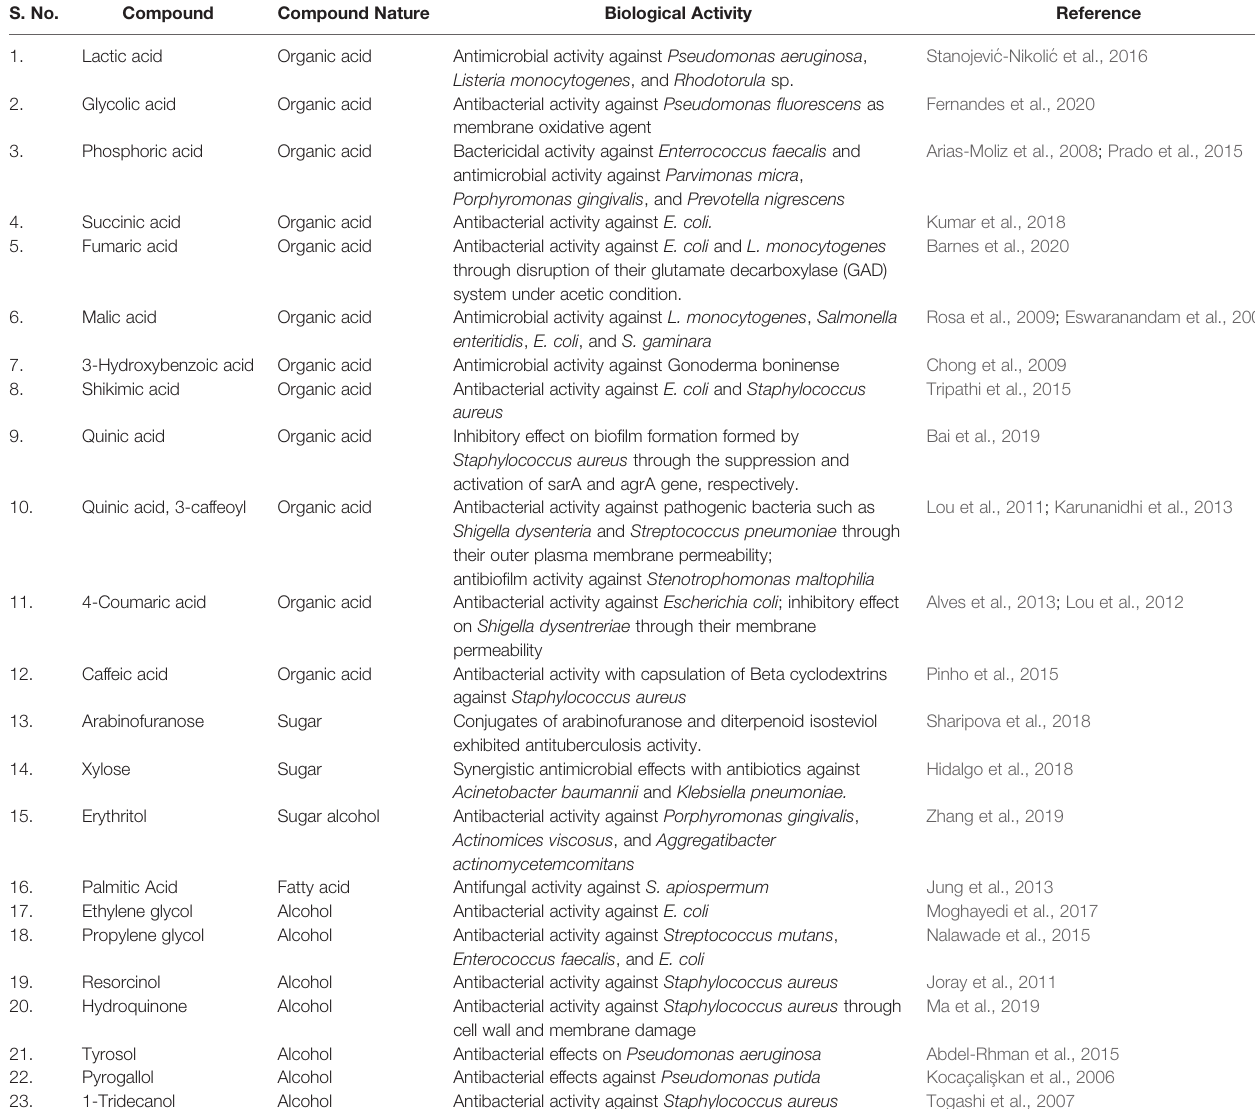
TABLE 4 | Antimicrobial metabolites identi fi ed in GC-MS analysis of U. indica bulb extract. S.